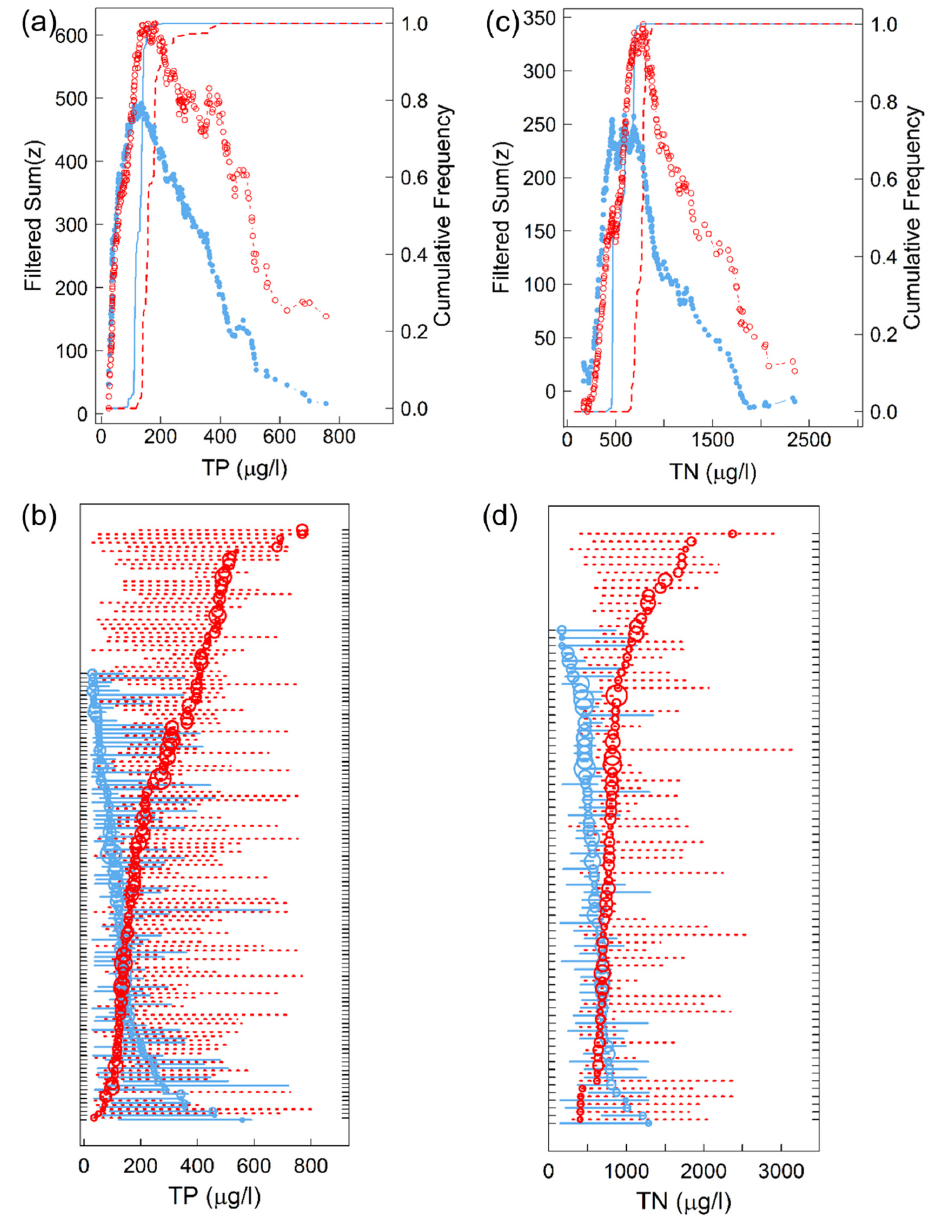
Figure 3. Threshold indicator taxa analysis showing sumZ scores and change points of ASVs for TP ( a , b ) and TN ( c , d ). Filtered refers to results using only ASVs identified as being pure (consistent response direction in >95% of bootstrap replicates) and reliable (consistently significant responses in >95% of bootstrap replicates). Red shows increaser sumZ scores and ASVs; blue shows decreaser sumZ scores and ASVs. For ( a , c ), circles show the sumZ scores of decreaser and increaser ASVs at each observed nutrient concentration, and cumulative frequencies show the distribution of assemblage change points (max sumZ) based on 100 bootstraps. For ( b , d ), open circles show change points for each ASV (y-axis tick marks) scaled according to magnitude of z scores, and dotted lines show the 5th and 95th quantiles based on 1000 bootstraps. Narrow peaks in sumZ scores, steep increases in the cumulative frequency curves, and multiple ASV change points occurring within a narrow range of TP or TN concentrations suggest nutrient thresholds at these concentrations. Broad peaks in sumZ scores, gradual increases in cumulative frequency curves, and gradual addition of ASV change points indicate more gradual responses to nutrient concentration and a longer gradient of community